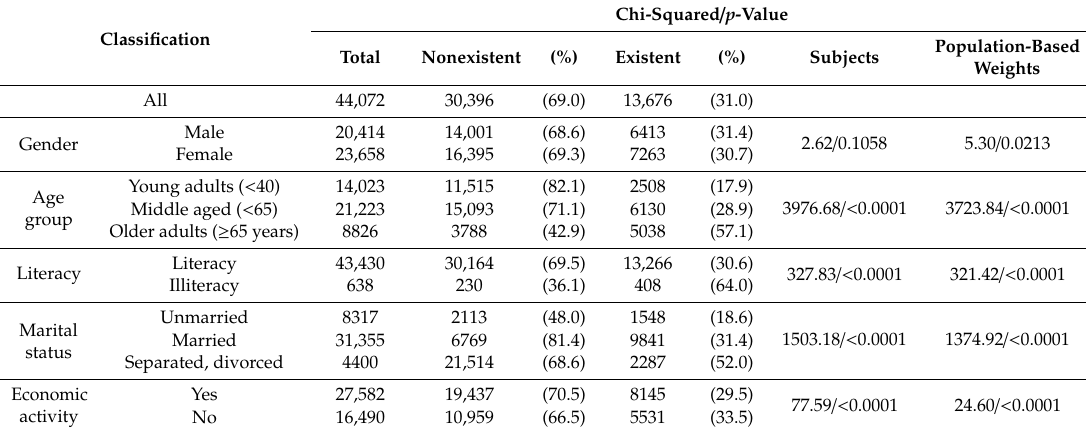
Table 2. Prevalence of food-chewing discomfort by sociodemographic characteristics.